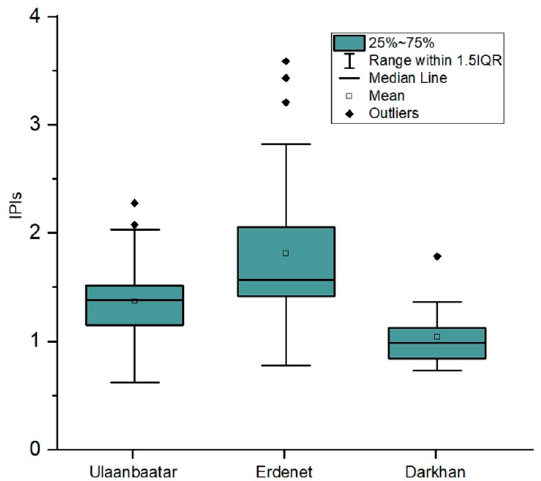
Figure 3. Boxplots of the integrated pollution index values for total sampling sites within this study from each city (Ulaanbaatar, Erdenet, and Darkhan).